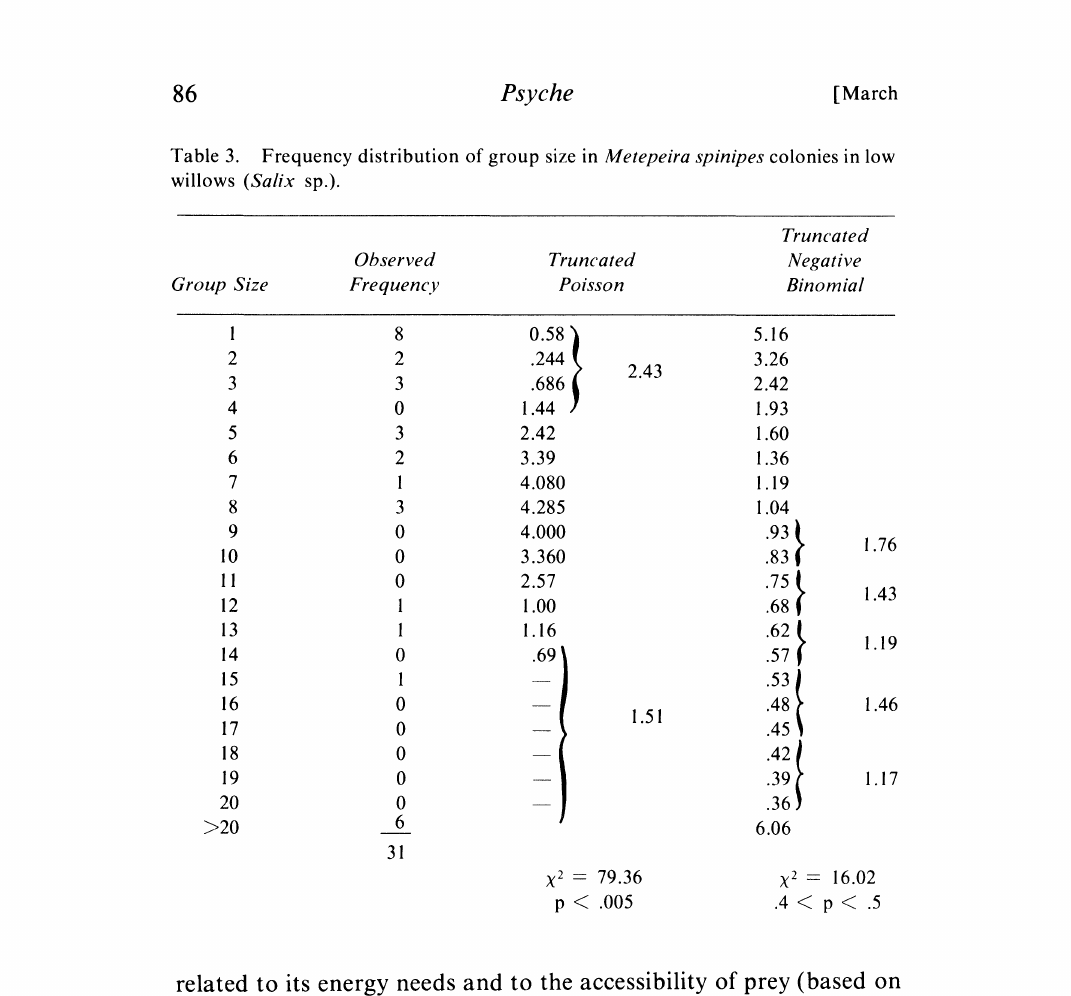
Psyche [March Table 3. Frequency distribution of group size in Metepeira spinipes colonies in low willows (Salix